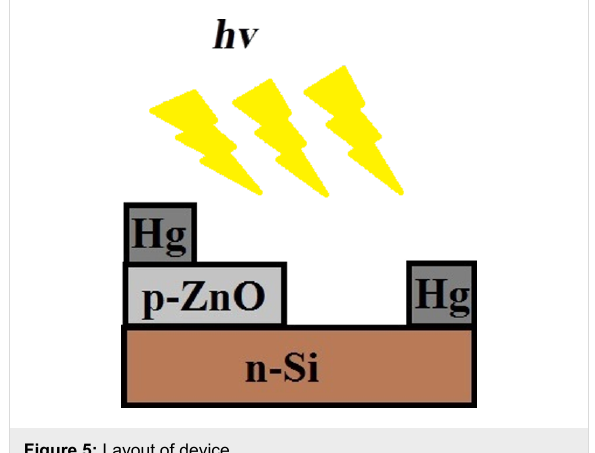
Figure 5: Layout of